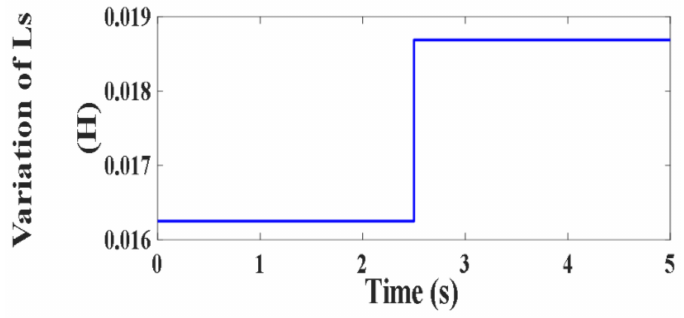
Figure 96. Variation of L s